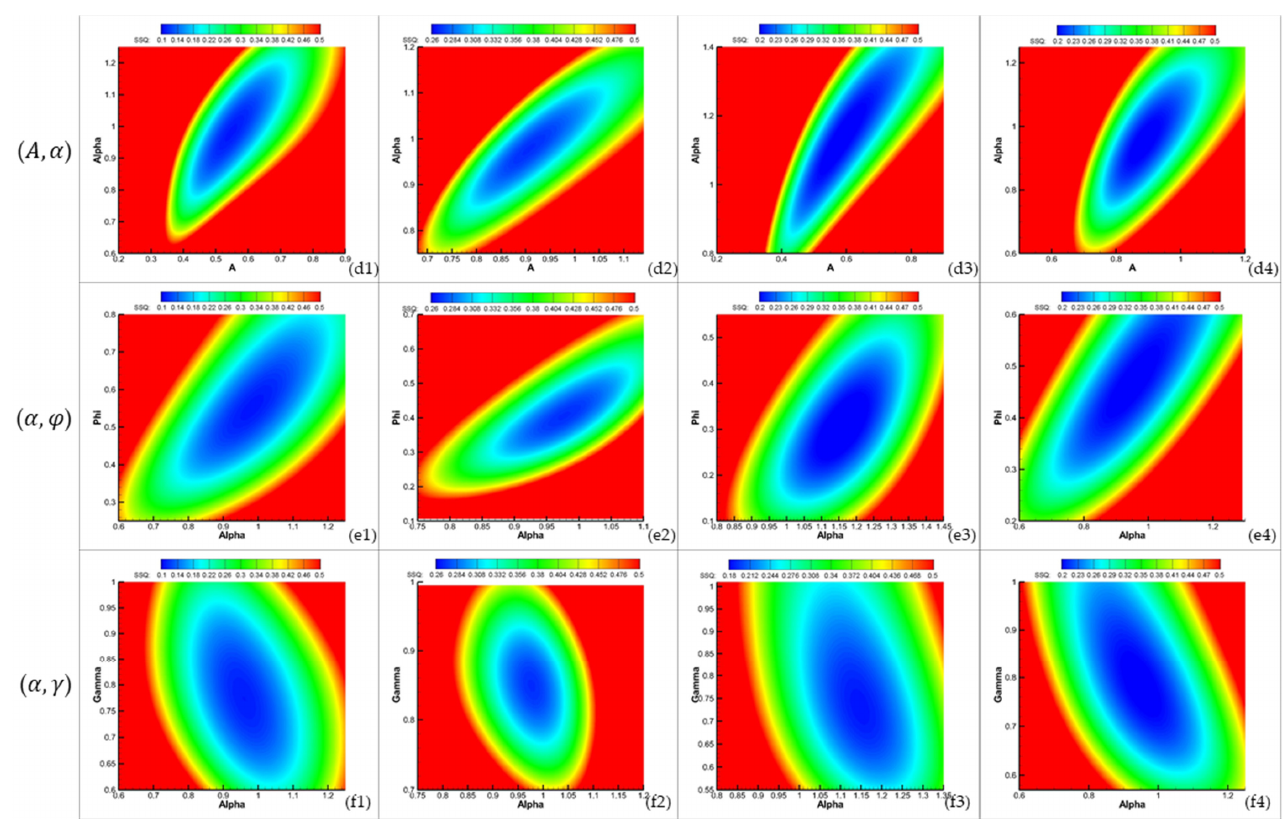
Figure 6. Distribution of SSQ (cid:3033)(cid:3036)(cid:3051) with various BFPs. The range of legend values for color representation is set to clearly depict the distribution near the minimum point.